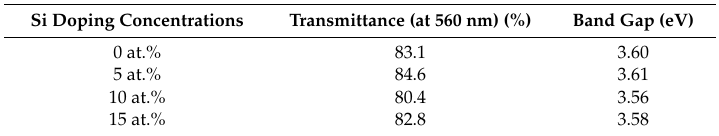
Table 1. Optical parameters of SnO 2 :Si thin films with different Si doping concentrations. Si Doping Concentrations Transmittance (at 560 nm) (%)